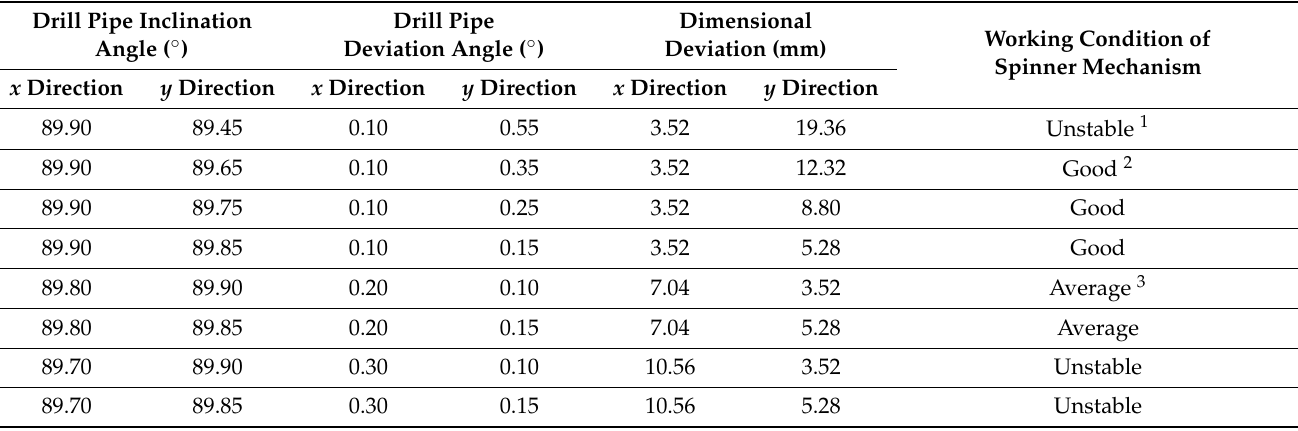
Table 4. Position deviation of the drill pipe and spin condition of the spinner mechanism with single follow-up